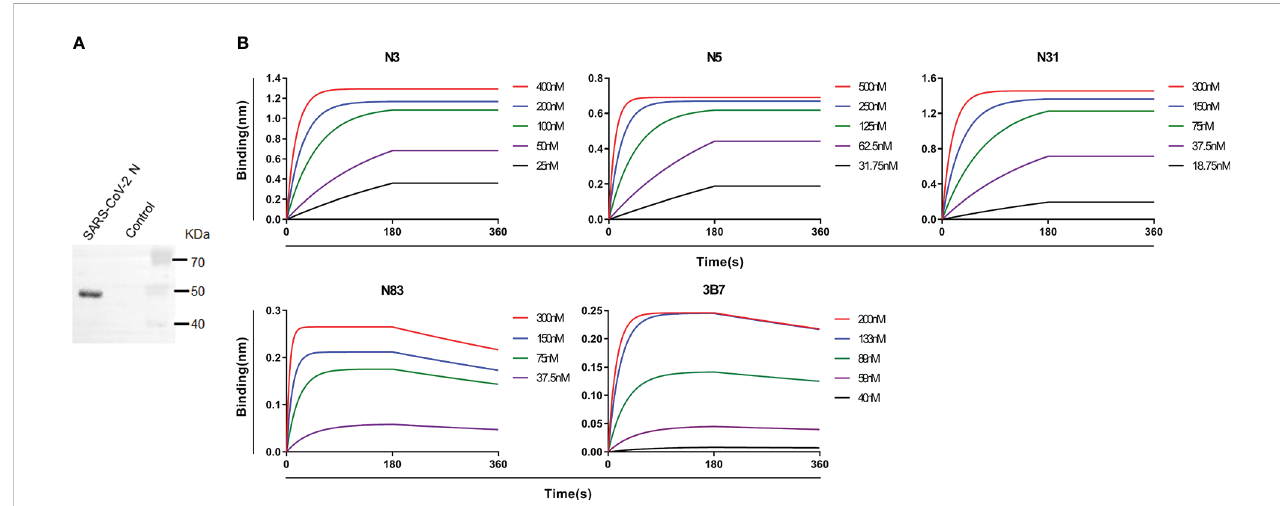
FIGURE 1 Isolation and characterization of patient – derived mAbs to SARS – CoV – 2 N protein. (A) Western blot showing SARS – CoV – 2 N protein in the supernatant of transfected 293 T cells. Supernatant from 293 T cells transfected with empty pcDNA3.1 vector was used as a control. (B) BLI results showing the af fi nities of 5 patient – derived mAbs to SARS – CoV – 2 N protein. The N protein was captured by anti – tag Ab with biotin labeling, which was immobilized on SA sensor. The data of association and disassociation between hmAbs and N protein were acquired on an Octet K2 platform. Experiments were repeated at least 3